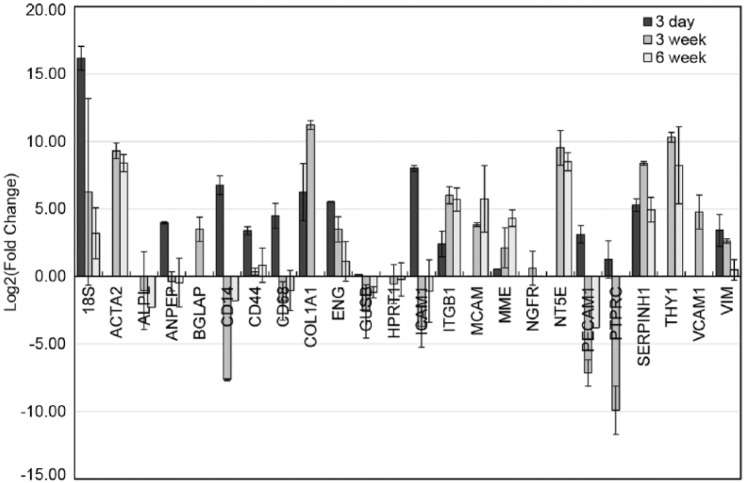
Relative fold change in the gene expression between 3-day-, 3-week-, and 6-week-conditioned heart valves in relation to their respective pre-seeded cell populations. Changes in gene expression are displayed as the Log2 of the average relative fold change within a group. Error bars represent the standard deviation.